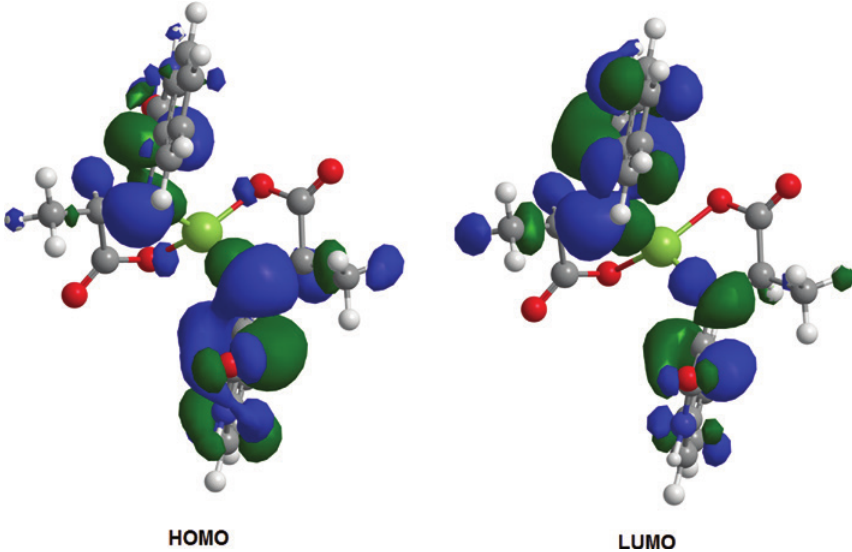
Figure 3: HOMO and LUMO orbitals of the compound Sn(L 1 )